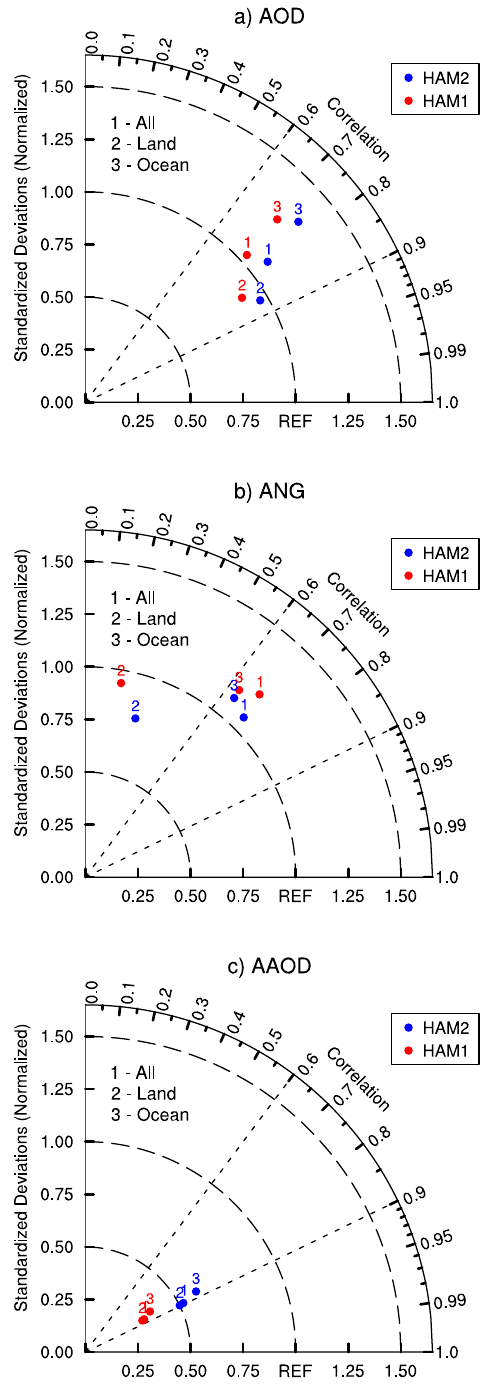
Fig. 18. Taylor diagrams comparing the simulated annual mean aerosol radiative properties with (a) MODIS aerosol optical depth (AOD), (b) MODIS ˚Angstr¨om parameter (ANG), and (c) aerosol absorption optical depth (AAOD) from Kinne et al. (2012). The corresponding zonal mean plots and global mean values are shown in Fig. 17.